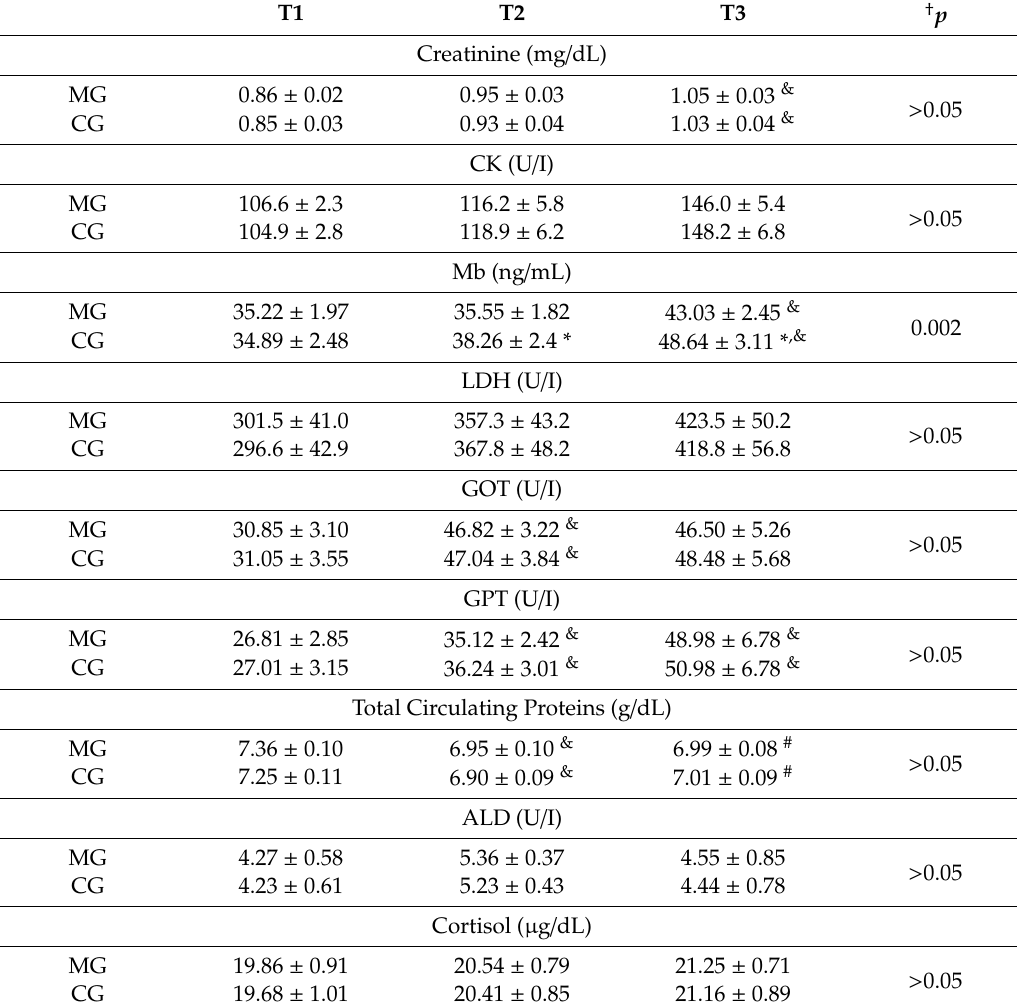
Table 4. Circulating markers of the magnesium group (MG) and control group (CG) at the beginning (T1), half race (T2) and end of the race (T3). T1